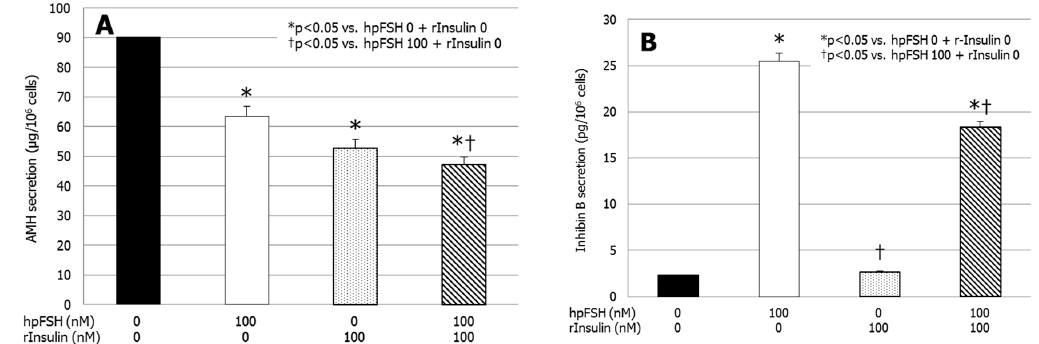
Figure 2. Secretion of ( A ) anti-Müllerian hormone (AMH) and ( B ) inhibin B. Data represent the mean ± SEM of three independent experiments, each performed in triplicate. * p < 0.05 vs. control; † p < 0.05 vs. hpFSH (one-way